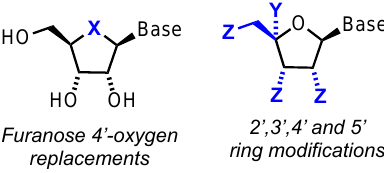
Figure 2. General scope for nucleoside analogues covered in this review. Base = purine or pyrimidine (i.e., C, U, T, A, G or close derivative thereof). X = heteroatom or carbon and Y and Z = ring functional